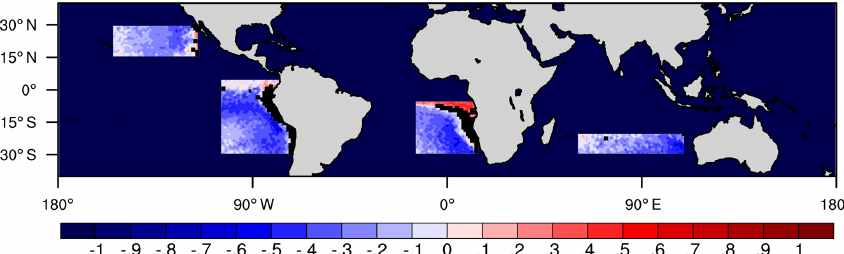
Figure 5. Map of s lwp which was obtained from bivariate linear regression of daily lnLWP, ln N d , and ln H BL retrievals at a spatial scale of 1 ◦ × 1 ◦ . Regions where s lwp is not statistically significant are masked in black.